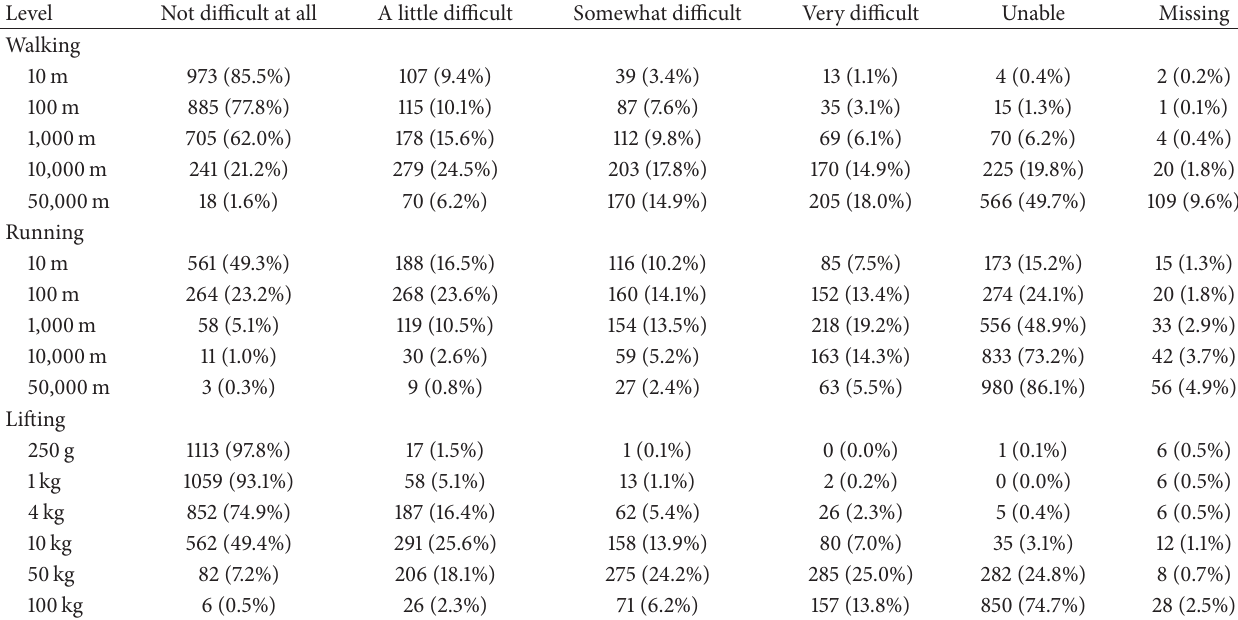
Table 2: Distribution of responses to walking, running, and lifting ability questions in the study sample ( 𝑛 = 1,138).